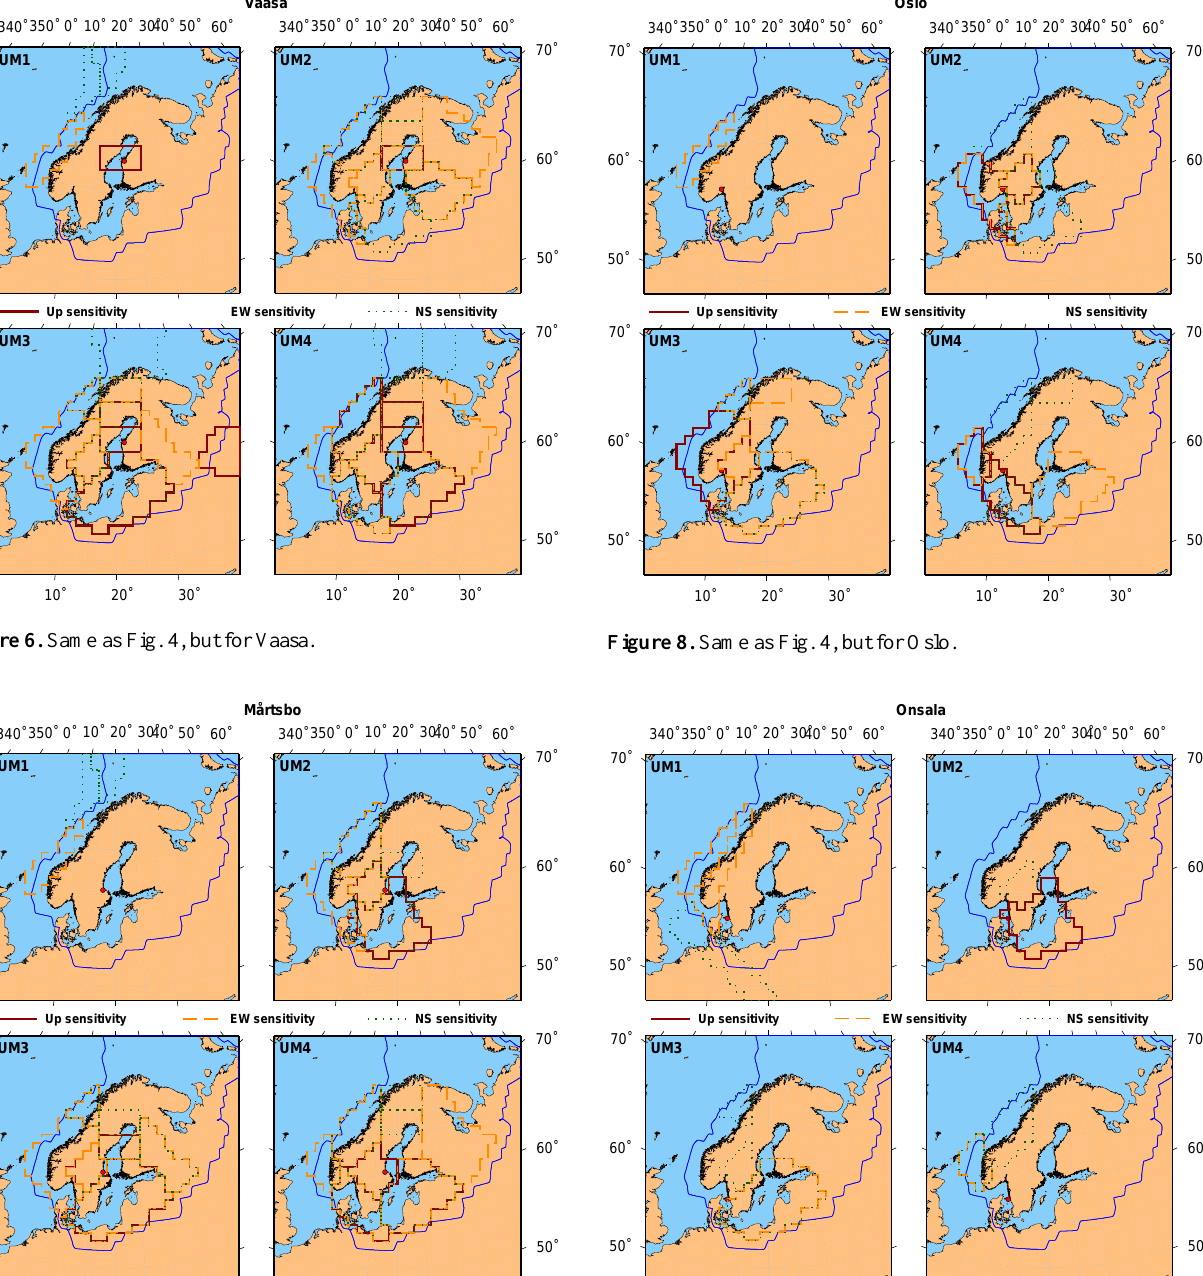
Fig.7. SameasFig.4,butforM˚artsbo. Figure 7. Same as Fig. 4, but for Mårtsbo.